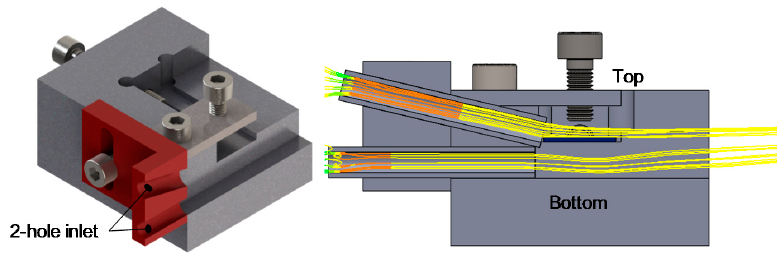
Figure 6. Optimization design of assisted gas flow solution with two-hole inlet structure.